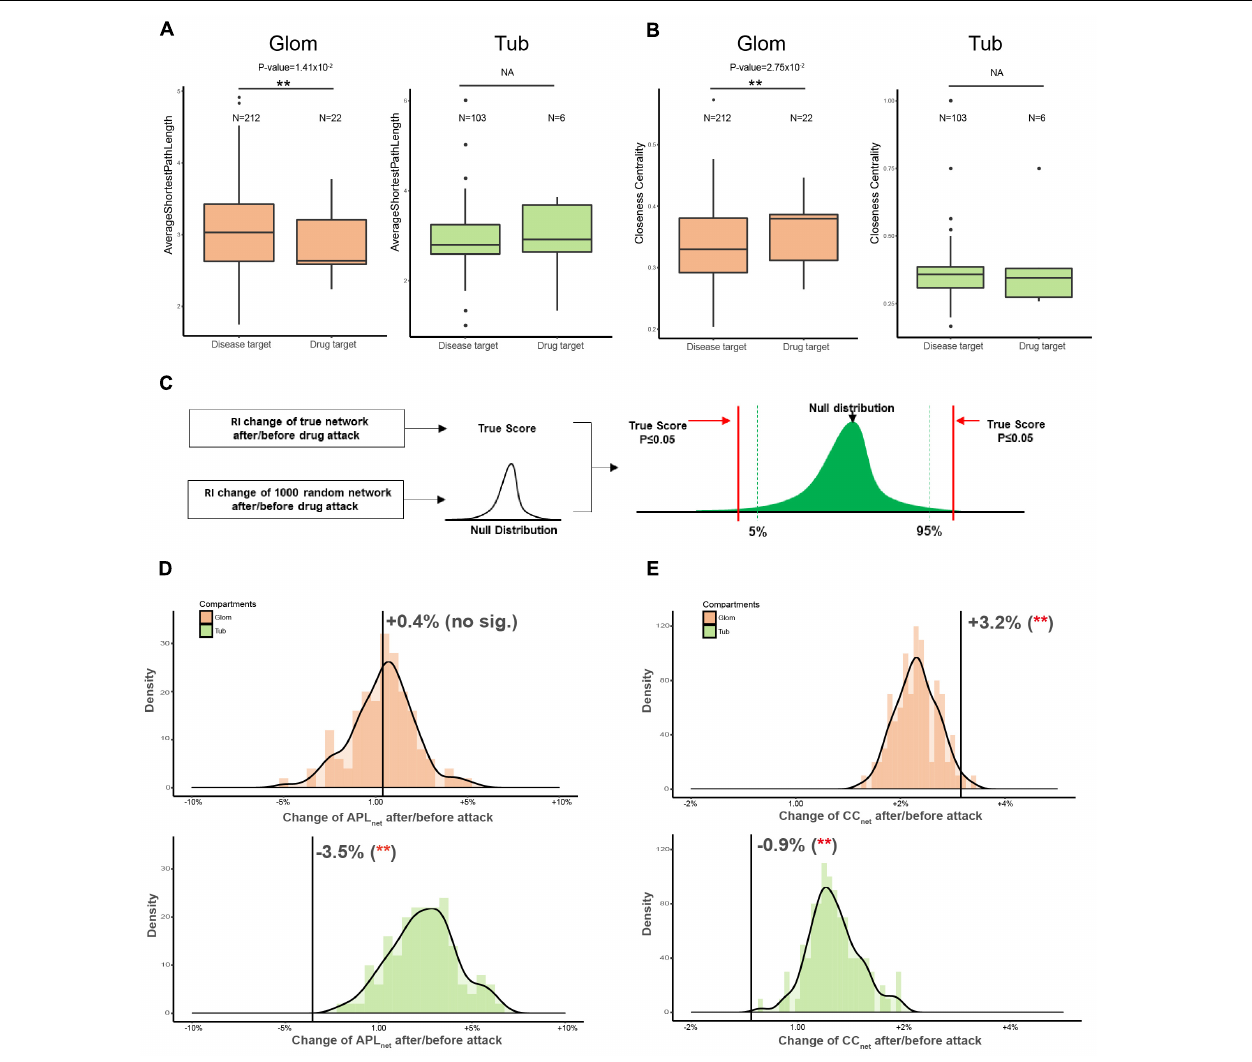
FIGURE 4 | Comparison of topological features of drug-attacked node in tubulointerstitial and glomerular network. (A,B) Boxplot of APL node (A) and CC node (B) of drug-attacked nodes and other nodes in tubulointerstitial and glomerular network. ∗∗ p -value < 0.05. (C) Schematic diagram of Permutation test. Network topological features were used as robustness indicators (RI) of networks. Null distribution of RI of 1000 random network was generated to maintain the same edge number of the true network and randomize interactions between nodes. Comparing with the null distribution, statistical significance of RI of true network can be calculated. (D,E) Robustness (APL net for D , CC net for E ) of glomerular and tubulointerstitial network versus random network (green distribution for tubules and orange distribution for glomeruli). X -axis is the percentage change of robustness indicators before/after attack. ∗∗ p -value <